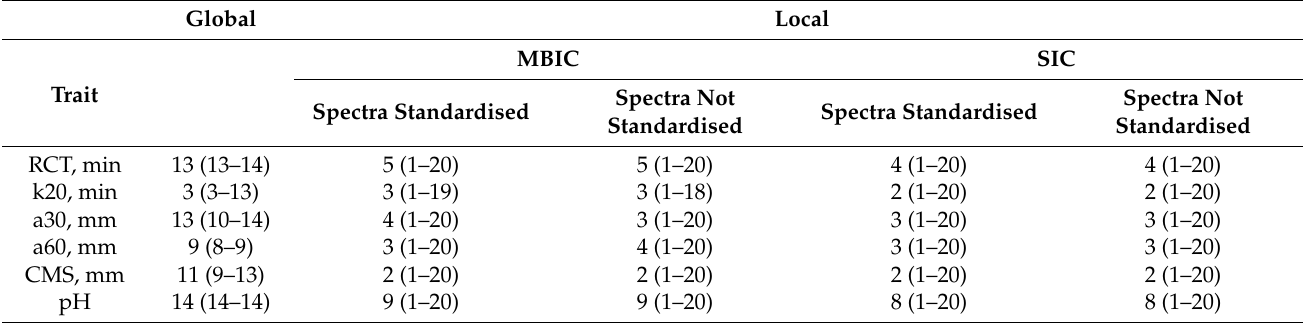
Table 5. Median (range in parentheses) number of factors used to run the global PLSR, as well as the median (range in parentheses) number of factors used to run local changepoint PLSR. Results from the LOCAL approach are not reported, as a fixed number of PLSR factors are used for all the observations. Global Local